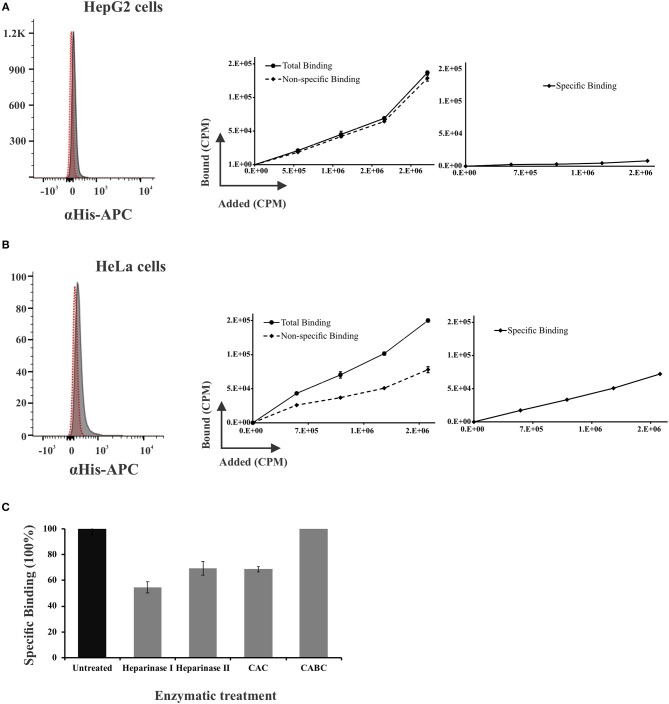
PvCelTOS specific binding to host cells. PvCelTOS was incubated with HepG2 (A) or HeLa cells (B). The protein's total binding was detected by flow cytometry using anti-histidine mAb. rPvCelTOS was radiolabelled and incubated with cells in the absence (total binding) or presence (non-specific binding) of non-radiolabelled protein (right-hand panel) for measuring its specific binding. The specific binding curve was calculated by subtracting total binding from non-specific binding. rPvCeltos binding to HeLa cells pre-treated with enzymes cleaving glycosaminoglycans. rPvCeltos binding to untreated HeLa cells was considered as 100% binding. Standard deviations were below 5%. (C). Flow cytometry was used for measuring total binding, with three lots of recombinant protein. The most representative experiment is shown. Radiolabelling assays were carried out in triplicate in two independent experiments.